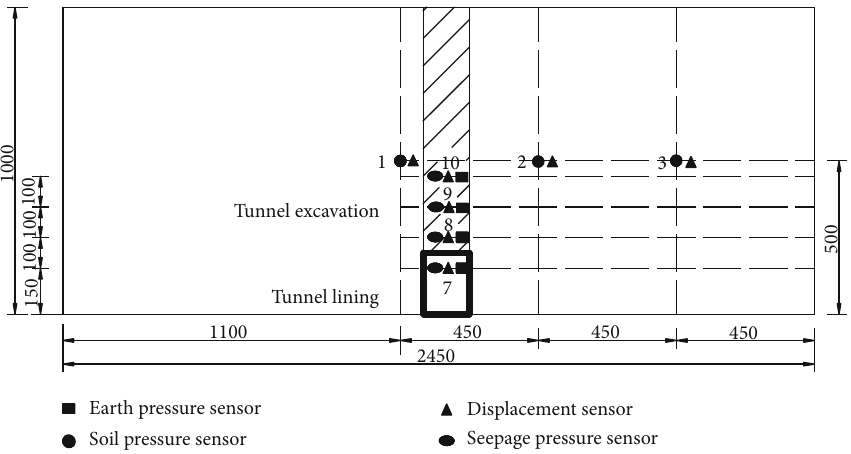
Figure 12: The top view of the tunnel-slope system model experiment (unit: